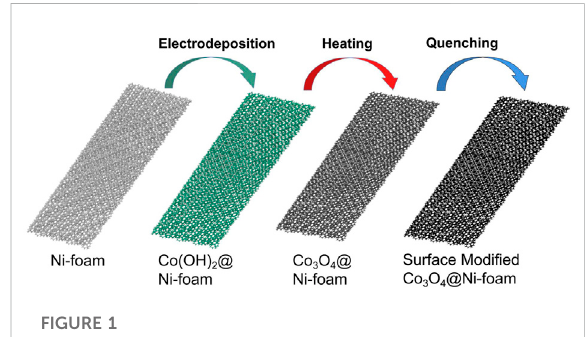
FIGURE 1 Schematic illustration of the preparation process of